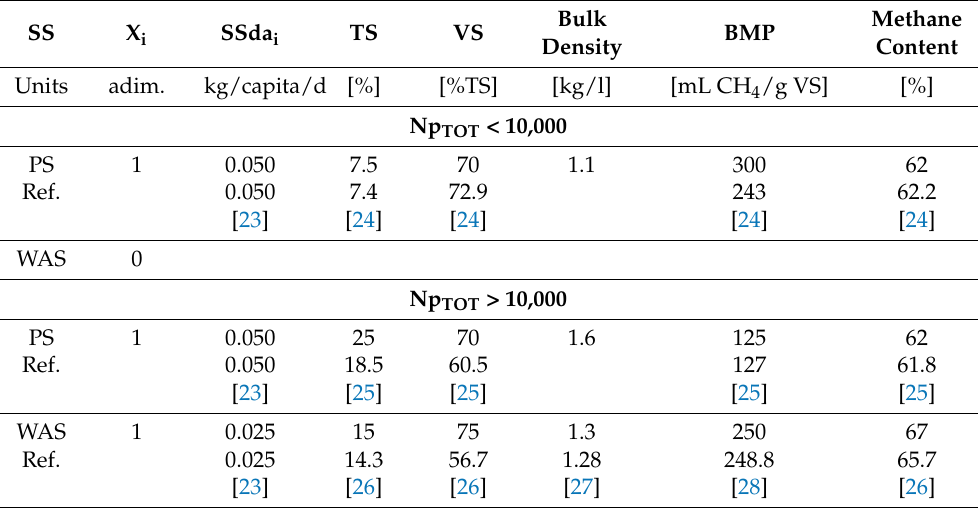
Table 2. Parameters assumed for the characterization of SS and the calculation of SS in .